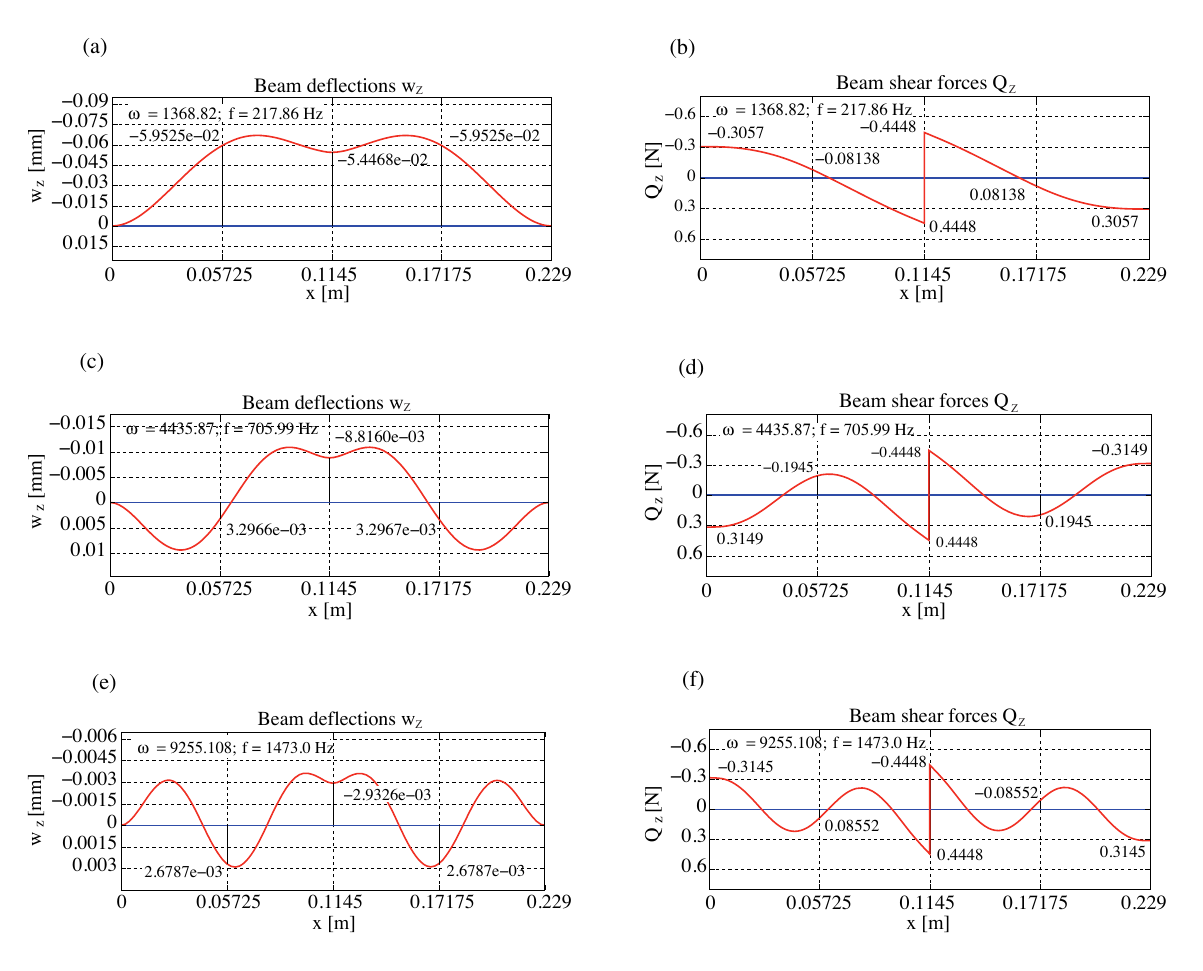
Fig. 11. Fixed-fixed beam deflection and shear force amplitudes at saddle point frequencies. Fig. 11. Fixed­fixed beam deflection and shear force amplitudes at saddle point frequencies.